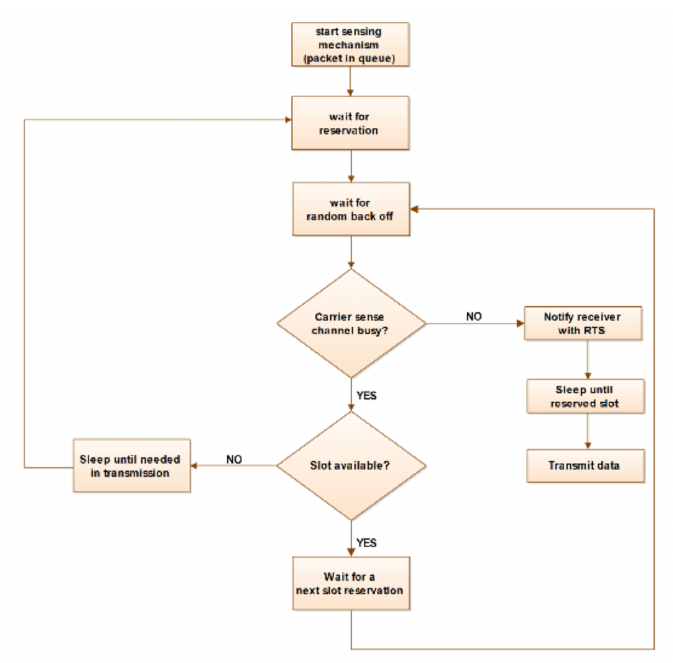
Figure 10. The structure of contention‑free